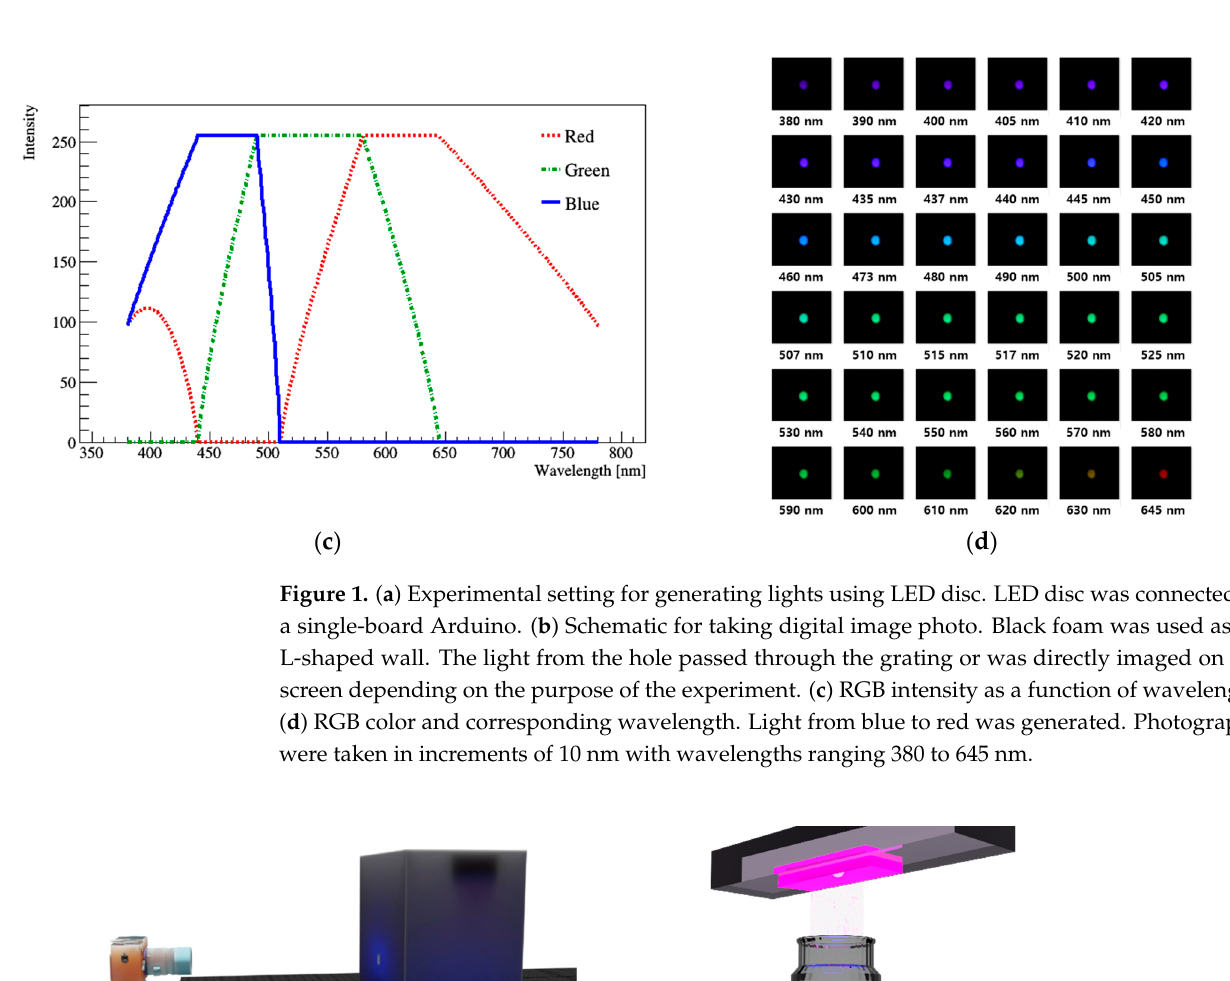
Figure 2. ( a ) Illustration of the experimental setup for taking digital images. A digital camera was remotely controlled. The WbLS sample was placed in a black box. There was a hole in the front of the box, and the light coming out through hole was photographed. ( b ) Schematic diagram showing the inside of the black box. A cylindrical quartz container was placed on top of the rotating disk,